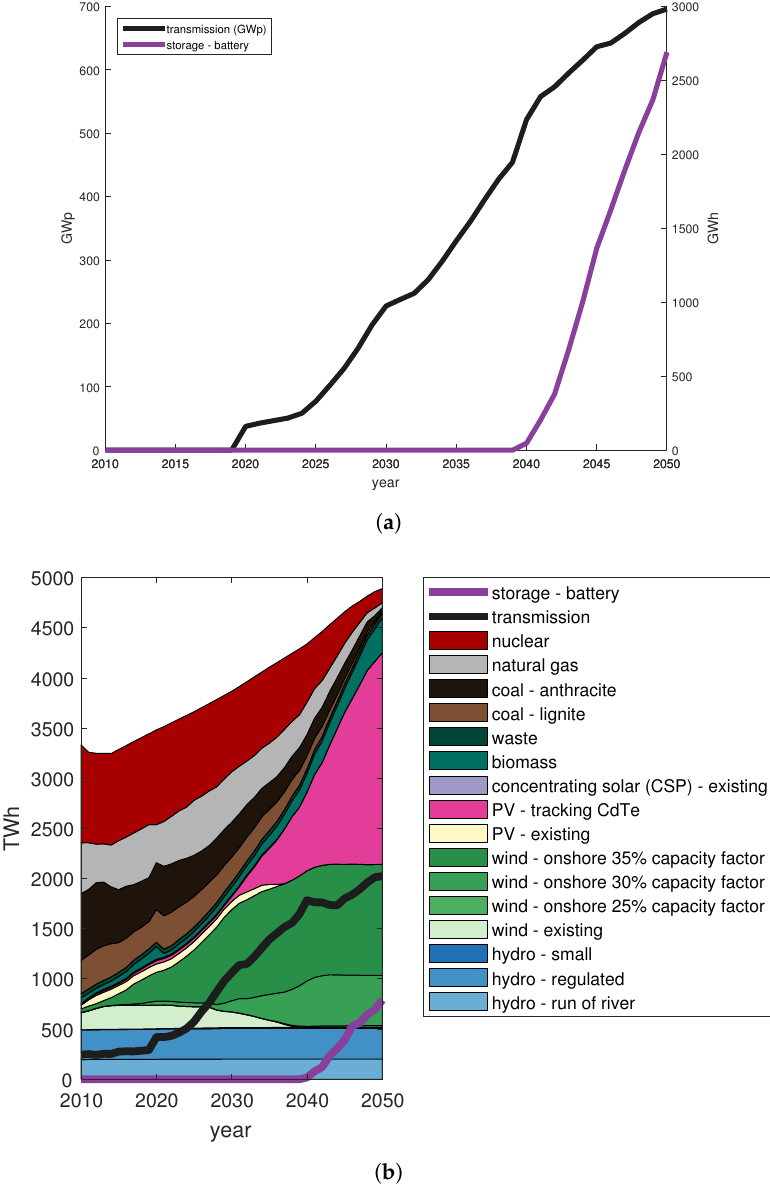
Figure 7. Model results for the lower storage cost scenario including ( a ) the capacity of new transmission (GW p ) and storage (GWh) investments, and ( b ) the electricity generated by generation type and year plus yearly electricity transmitted internationally and yearly energy transferred to storage. Note that the order of the legends for line and area plots corresponds to the order of the respective values in 2010 from top to